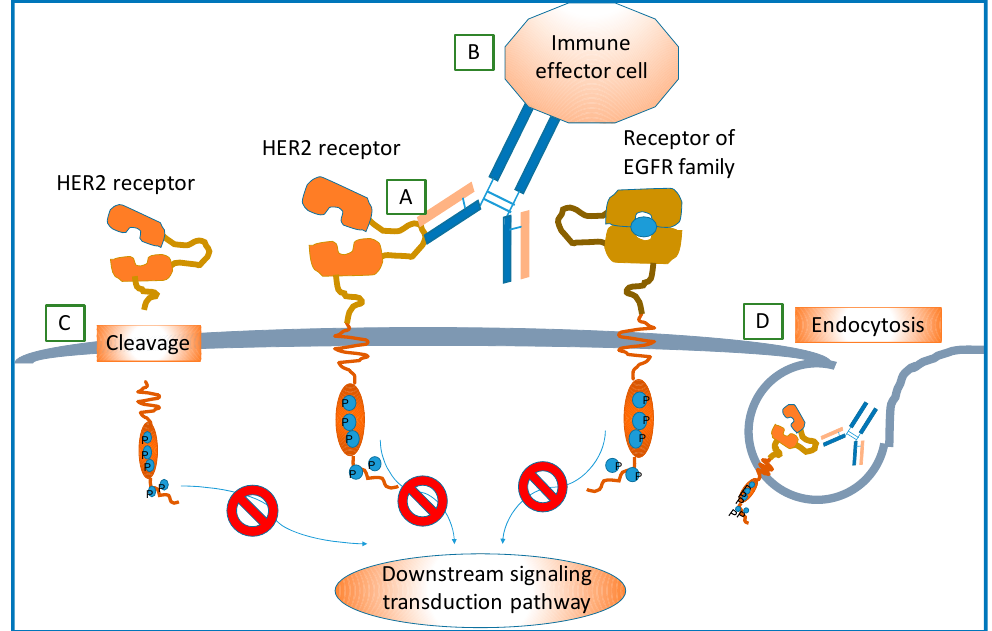
Figure 5. Potential action mechanisms of trastuzumab targeting HER2 receptor. ( A ) Blocking of the dimerization of HER2 and other EGF receptors; ( B ) Role of antibody-dependent immune-mediated response; ( C ) Binding of trastuzumab and HER2 may prevent HER2 extracellular domain from cleavage or shedding, which would further inhibit downstream signaling transductions and promote cell apoptosis; and ( D ) Endocytosis of HER2 receptor conjugated with trastuzumab. Reproduced based on Hudis’s work [59].